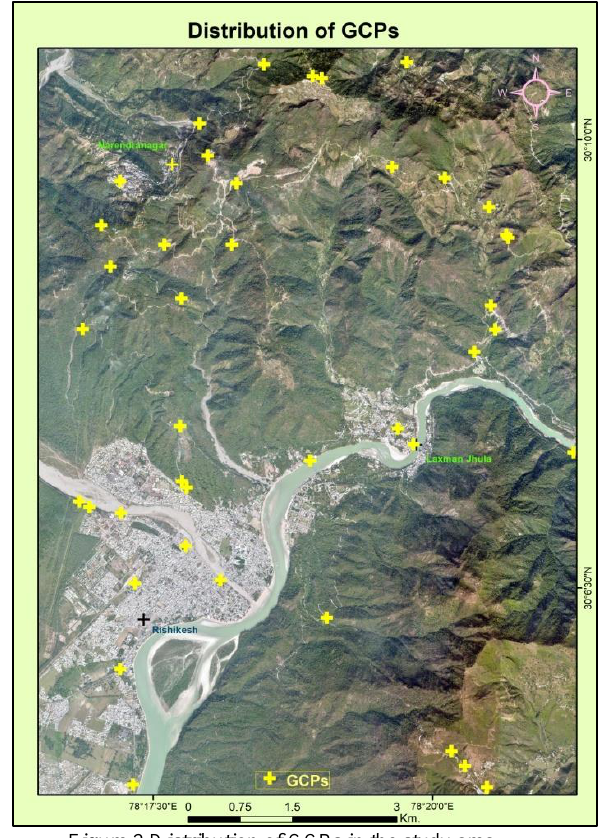
Figure 2 Distribution of GCPs in the study